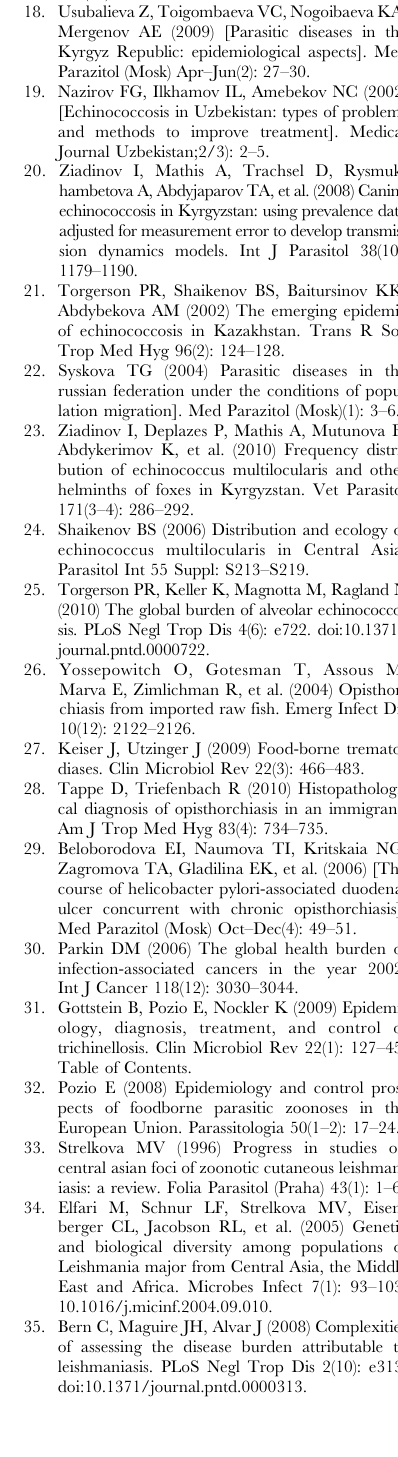
Table of Contents. 32. Pozio E (2008) Epidemiology and control